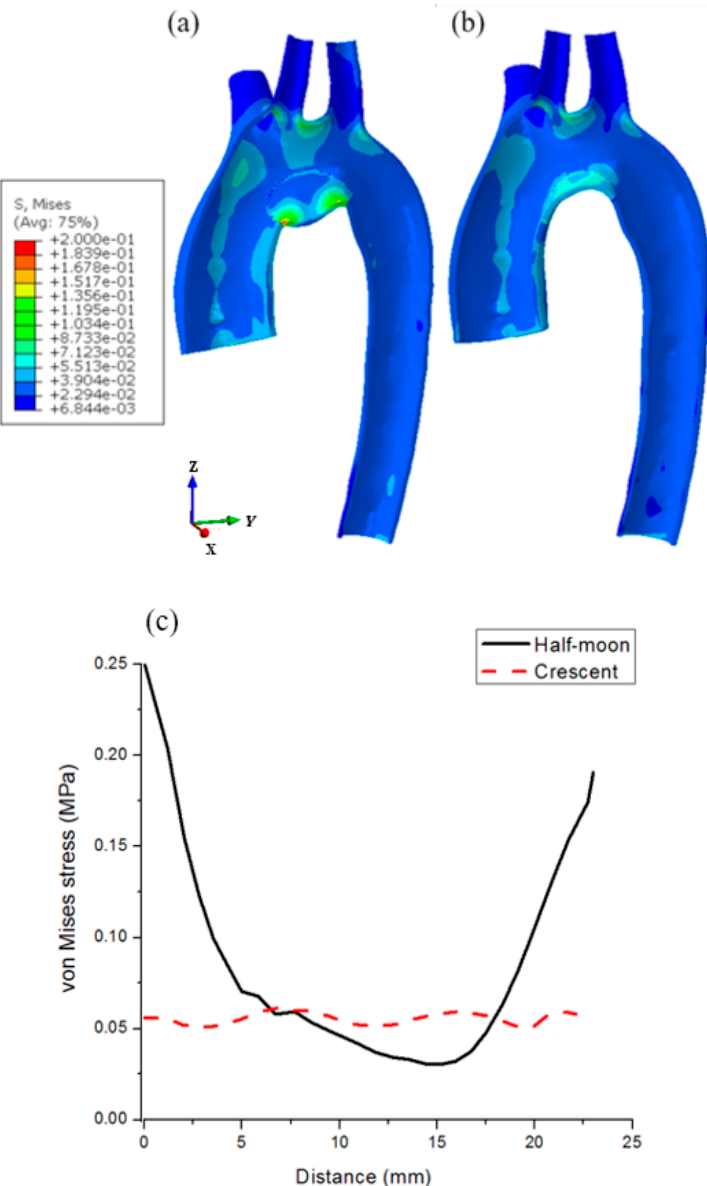
Figure 5. Stress distributions at t = 0.4 s (peak systolic pressure) on the ( a ) half-moon and ( b ) crescent pulmonary grafts; ( c ) von Mises stress across the graft zone along the lower border of the arch. The blood flow dynamics at 0.4 s (peak pressure, systole) and 0.6 s (early diastole) for both graft repairs are shown in Figure 6. Streamlines illustrate the helical blood motion while y-direction velocity vectors, without any projection at two representative cross sections (ascending aorta A-A (cid:48) and aortic arch B-B (cid:48) ), demonstrate the rotational flow. It is clear that flow disturbance was higher at the diastolic phase. The positive velocity magnitude represents the forward flow, and the negative one represents the reversed flow. The minimal flow disturbance was observed at the ascending aorta only at the diastolic phase. However, at the aortic arc, the reversed flow was observed during both the diastolic and systolic phases. The reversed flow was much more obvious in the half-moon graft than the crescent one. The reversed flow zone was minimal in the crescent graft. In addition, the reversed flow occurred around the inner curvature of the